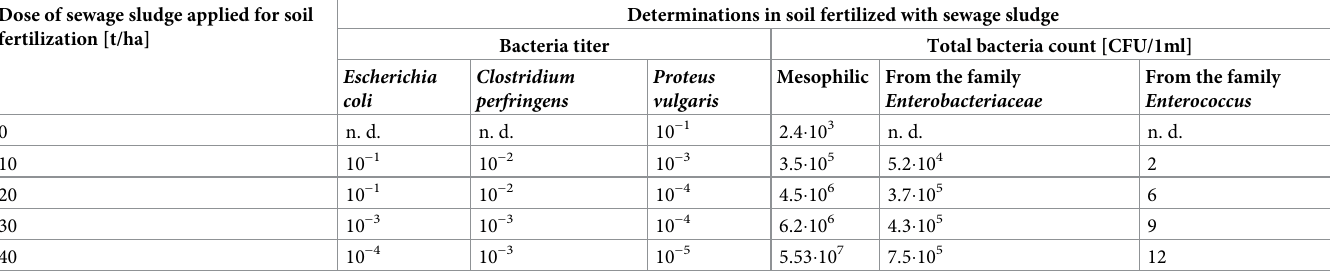
Table 3. Results of sanitary examinations of soil fertilized with different doses of sewage sludge (after completion of the experiment). Dose of sewage sludge applied for soil fertilization [t/ha]